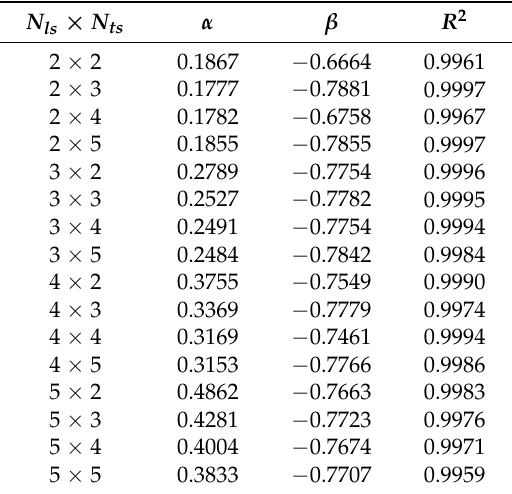
Figure 7. Central deflections of the stiffened plates due to h s / t s variation with ( a ) N ls = 2 and N ts = 2 to 5, ( b ) N ls = 3 and N ts = 2 to 5, ( c ) N ls = 4 and N ts = 2 to 5, and ( d ) N ls = 5 and N ts = 2 to 5. Table 1. Coefficients α , β , and R 2 for each combination of N ls and N ts Table 1. Coefficients α , β , and R 2 for each combination of N ls and N ts .